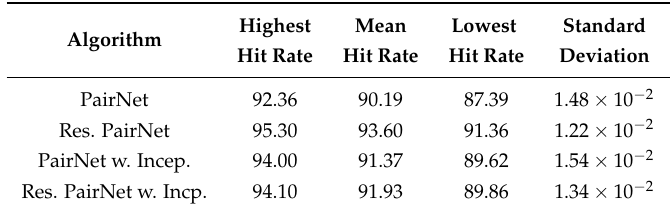
Table 5. Statistical evaluation on the hit rates (in percentage) of various